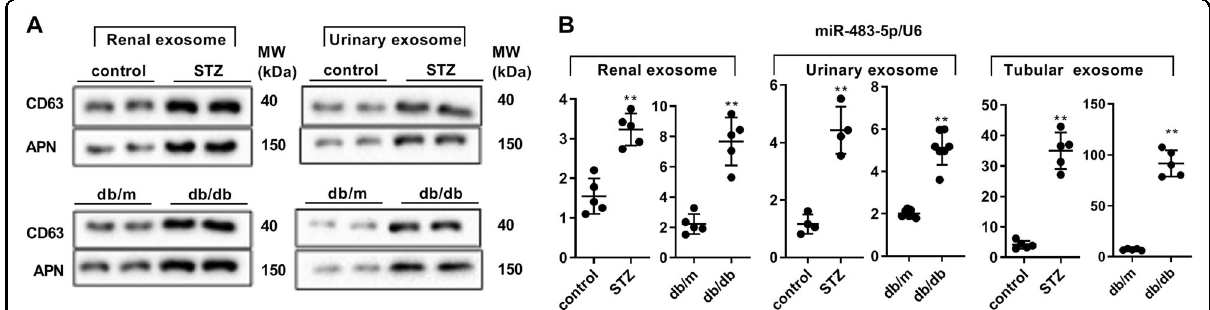
Fig. 6 Different expressions of miR-483-5p in the mouse model of diabetes in the exosomes derived from renal tissues, urine, and renal tubular. A Detection of CD63 and APN protein levels by western blot. B Detection of miR-483-5p expression by qRT-PCR. ** P < 0.01 vs. control or db/ m. Student ’ s t -test. of three independent experiments. STZ Streptozotocin, db/m db/misty, APN Aminopeptidase